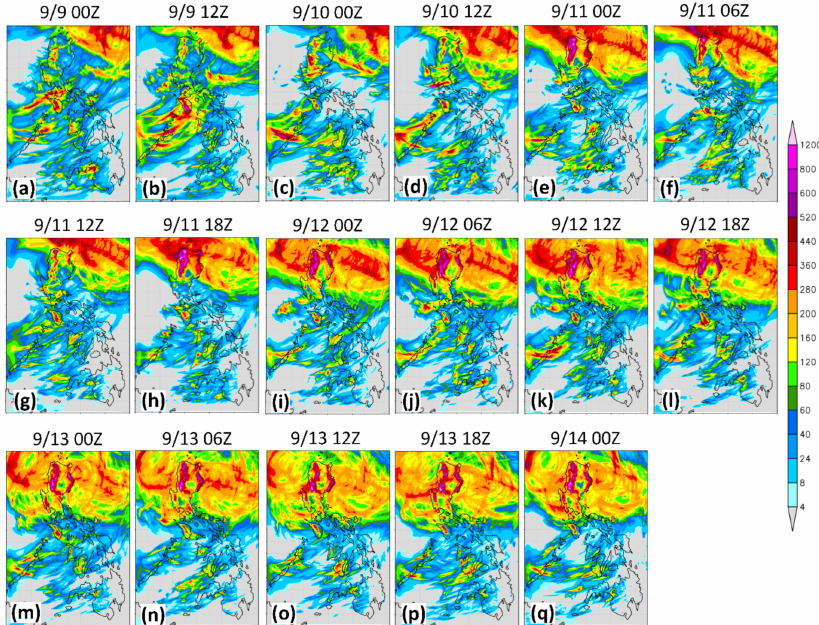
Figure 5. Predicted 48 h rainfall distributions (mm, scale to the right), all valid for the period from 0000 UTC on 14 September to 0000 UTC on 16 September during TY Mangkhut (2018), with the time-lagged forecasts every 12 h at the initial time from ( a ) 0000 UTC on 9 September to ( d ) 1200 UTC on 10 September, and every 6 h from ( e ) 0000 UTC on 11 September to ( q ) 0000 UTC on 14 September 2018, respectively. The color scale is the same for all panels. Some panels were shown in Part I